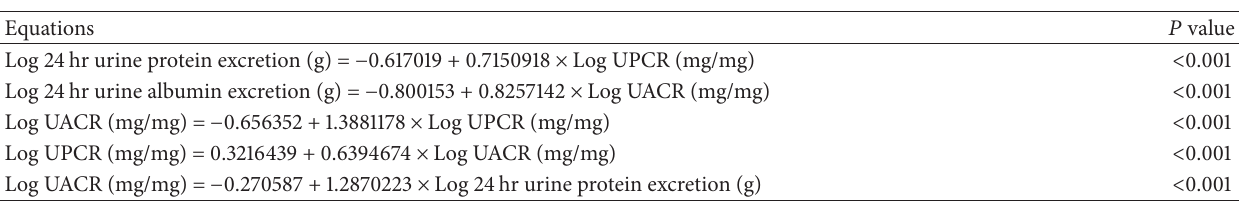
Table 2: Equations for converting spot estimates and 24 hr urine measurements. (a) Conversion predicting equations